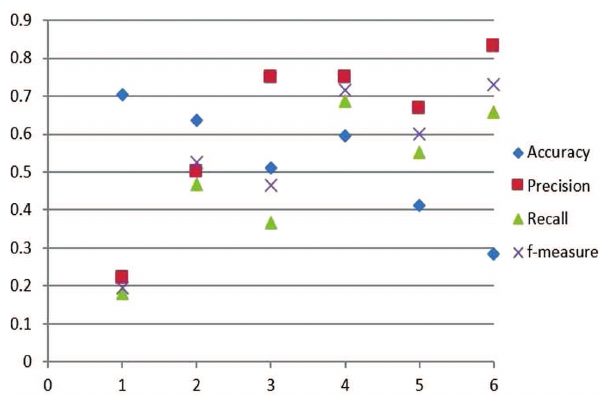
Figure 2: The Final TCP-GWO Responses to Clustering Documents.